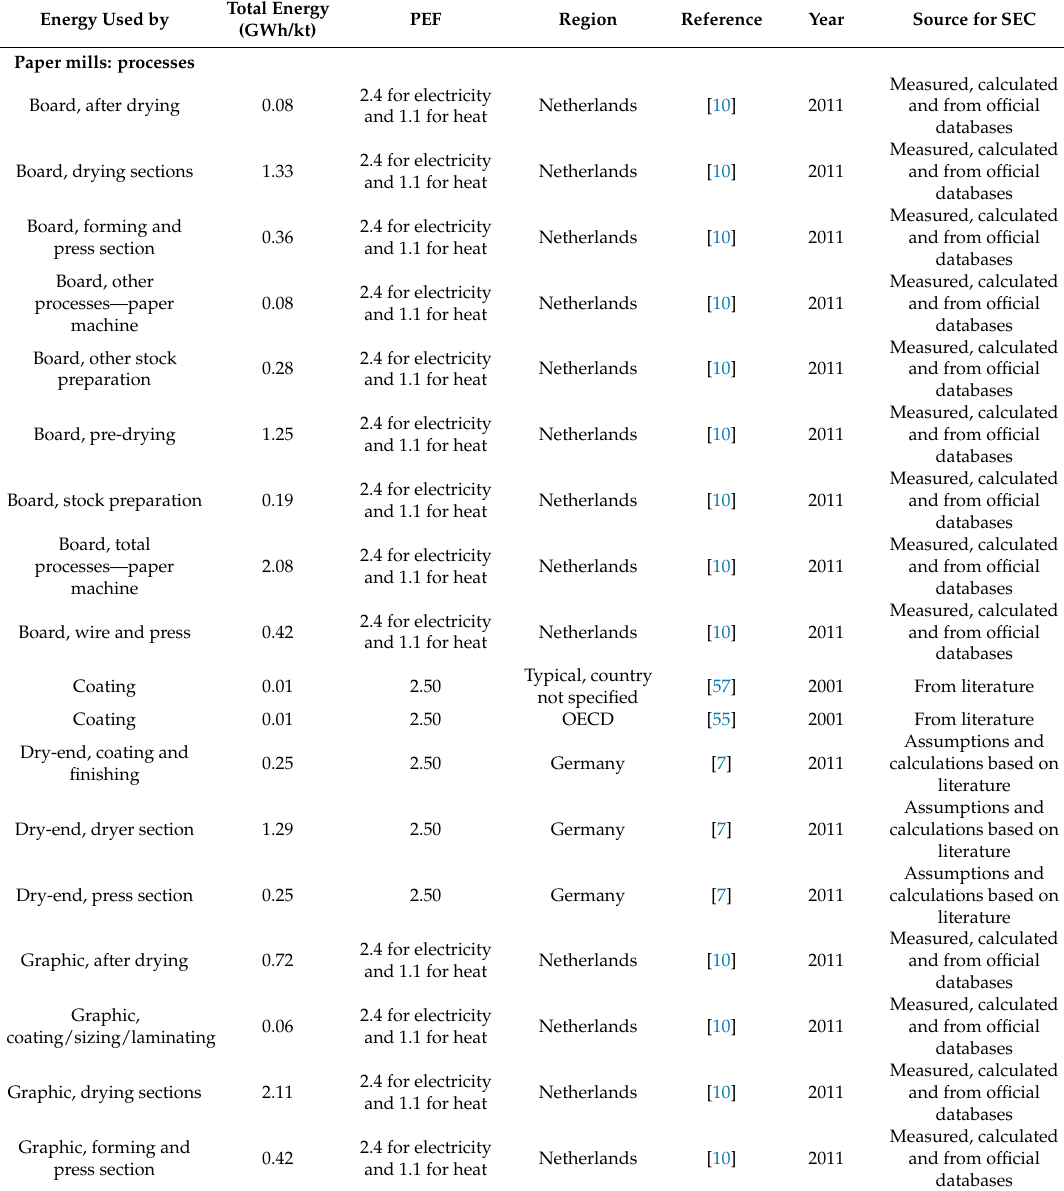
Table A4. Examples of SEC for various processes during pulp production, listed alphabetically. BAT—Best available technology. OECD—Countries that are members of the Organisation for Economic Co-operation and